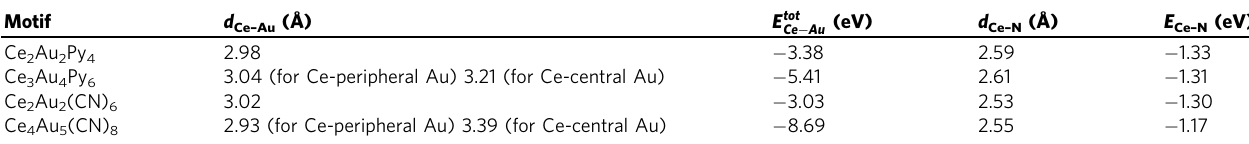
Table 2 Lengths and Energies of the Ce – Au and Ce – N bonds in the coordination